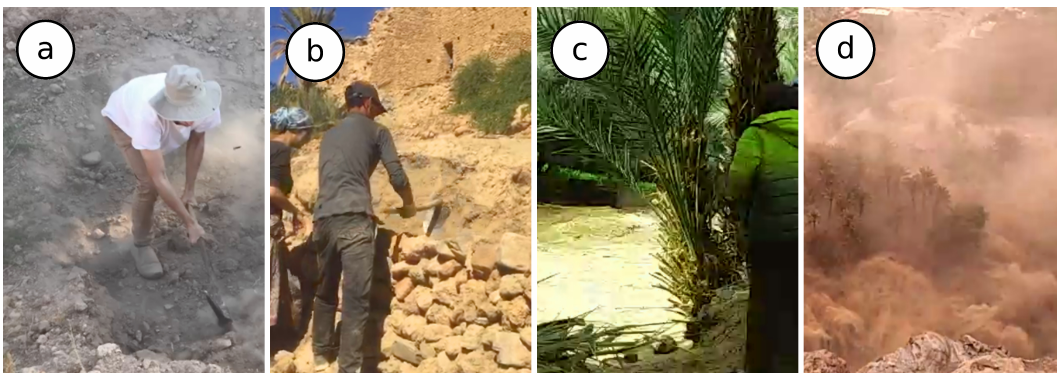
Figure 6. Field surveys and direct observation: ( a ) observation of the granulometry, type of rocks and roots effect on collapsed terraces. ( b ) Description of the local building techniques; farmers were asked to rebuild a collapsed terrace. ( c ) From videos taken by the inhabitants during the flood, the wet section and flow velocity in some sections of the wadi, have been estimated. ( d ) Excerpt from a video documenting the flood effect at the basin’s outlet.